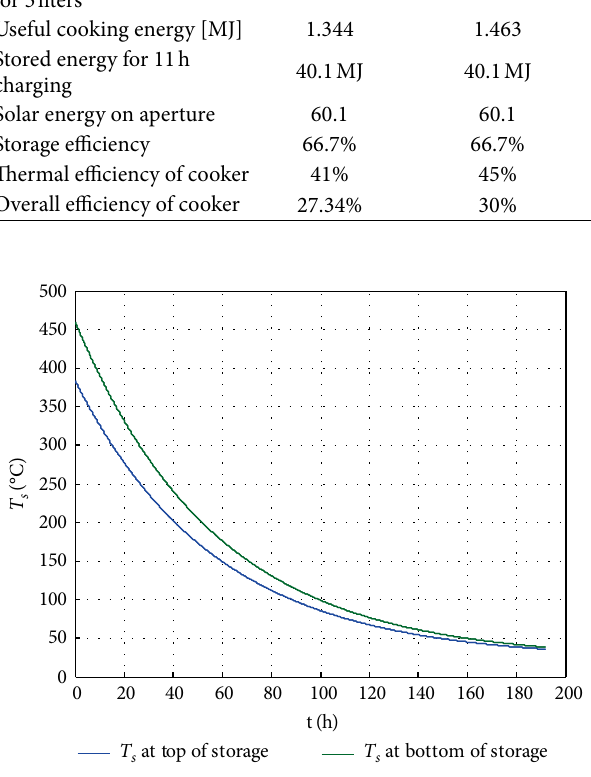
Figure 20: Temperature of storage when without operation with heat losses to the environment through insulation thickness of 75